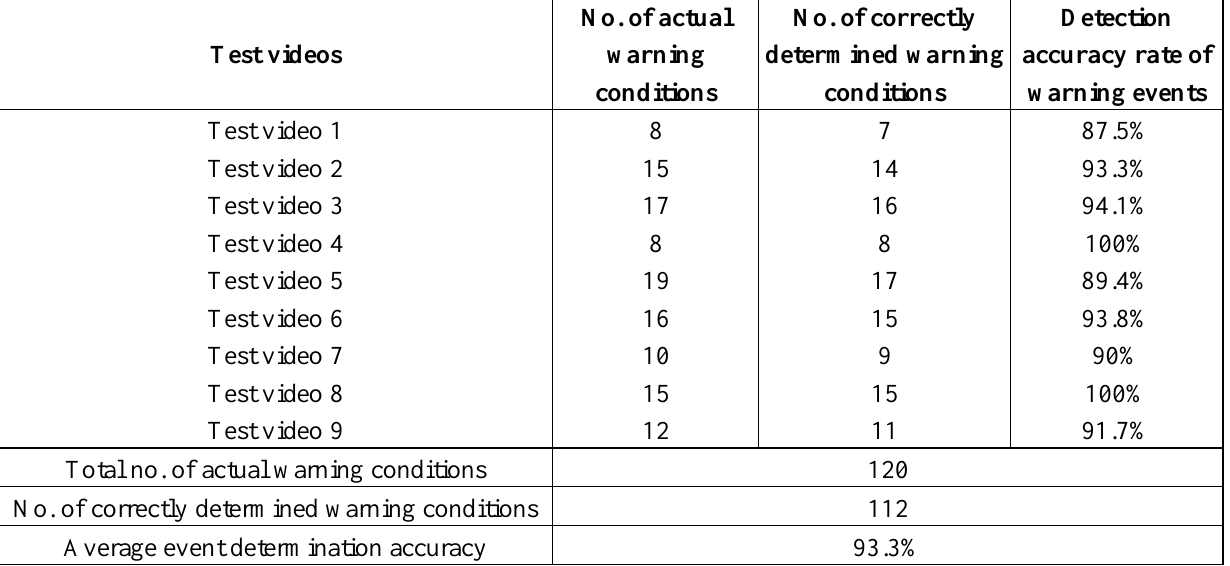
Table 2. Detection accuracy of the proposed system on warning event determination.